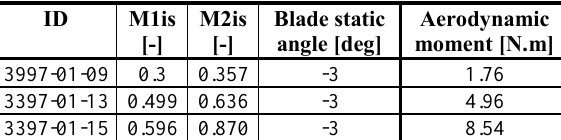
Table 1. Aerodynamic torque on the middle blade evaluated from static pressure measurements.